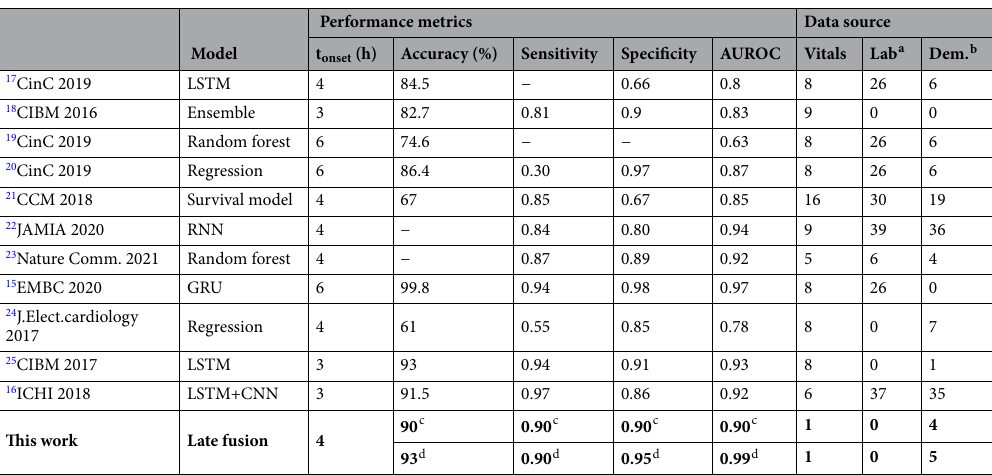
a Includes laboratory test results c late fusion of demographics and ECG.